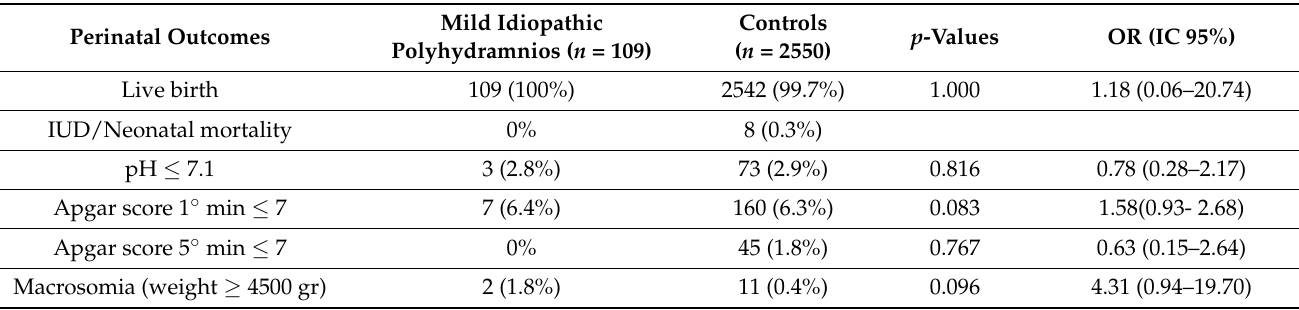
Table 4. Neonatal outcomes in the study population and control